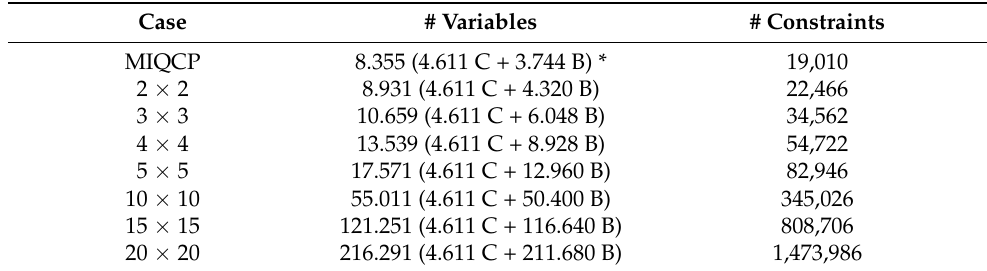
Table 1. Comparison of model